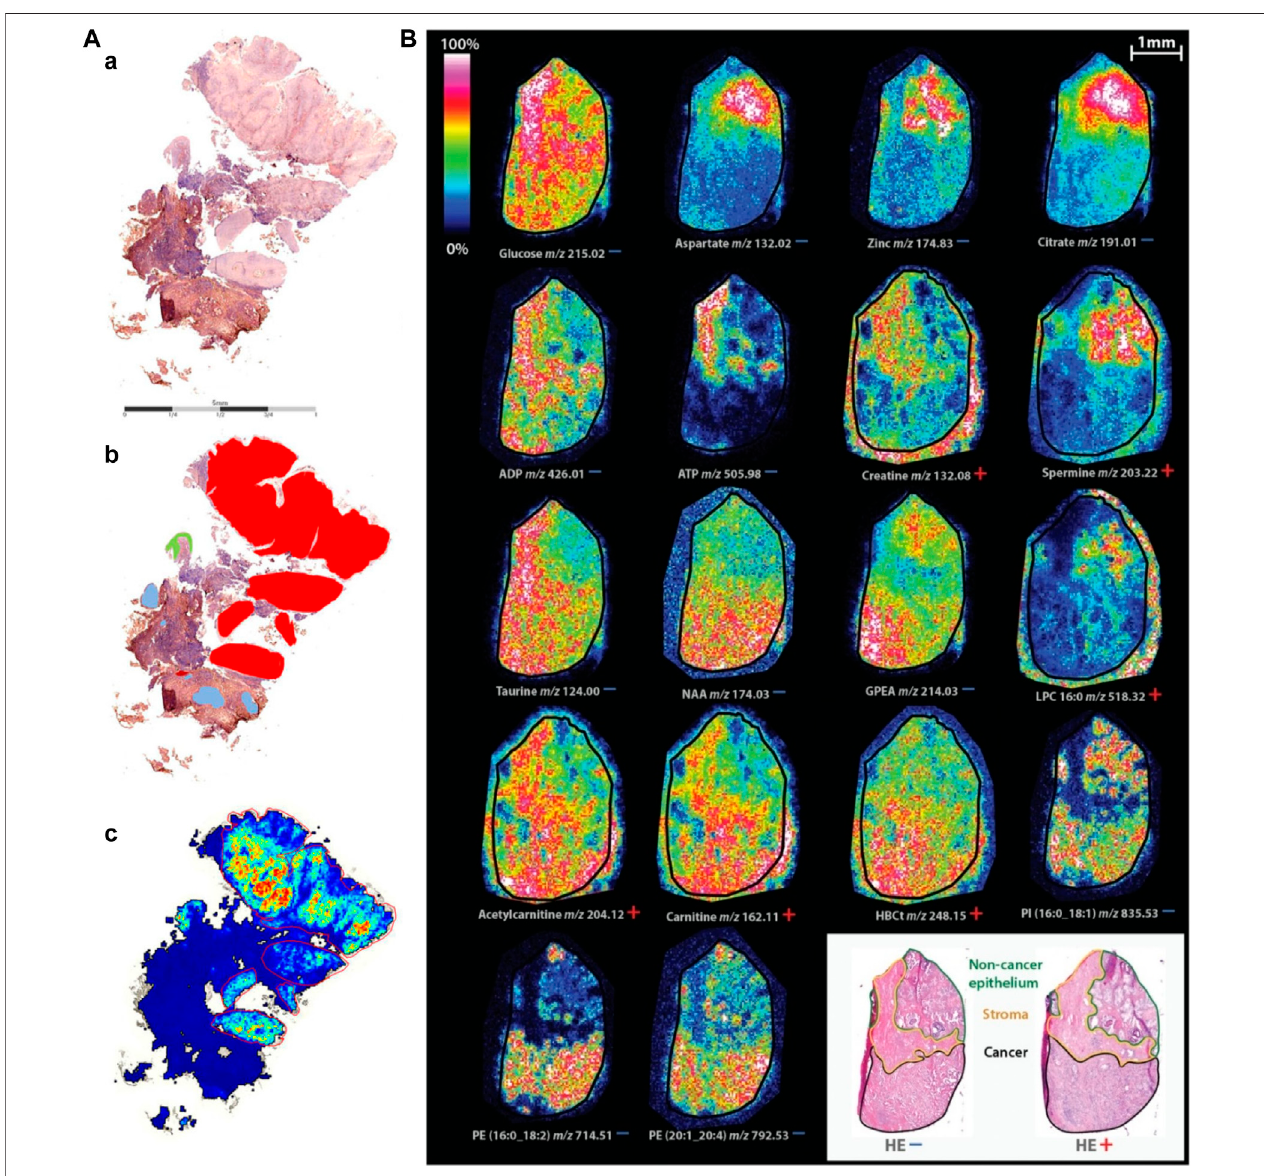
FIGURE 7 | Typical characterization of cancer and biomarker by MALDI-MSI. (A) Comparison of component analysis of MALDI-MSI measurements on FFPE sections with histopathological regions. One example of sample cohort is shown. (a) Hematoxylin and eosin-stained tissue section. (b) Annotated regions, red: squamouscell carcinoma, green: dysplastic epithelium, rest:nontumor region, containingconnectivetissue with in fl ammatory in fi ltration and glandular regions(blue). (c) Componentthatcoversthetumorregion;nospatialdenoisingwasperformed(Hoffmannetal.,2019). (B) Spatialdistributionofidenti fi edmassesinbothionmodes on consecutive tissue sections (Andersen et al.,